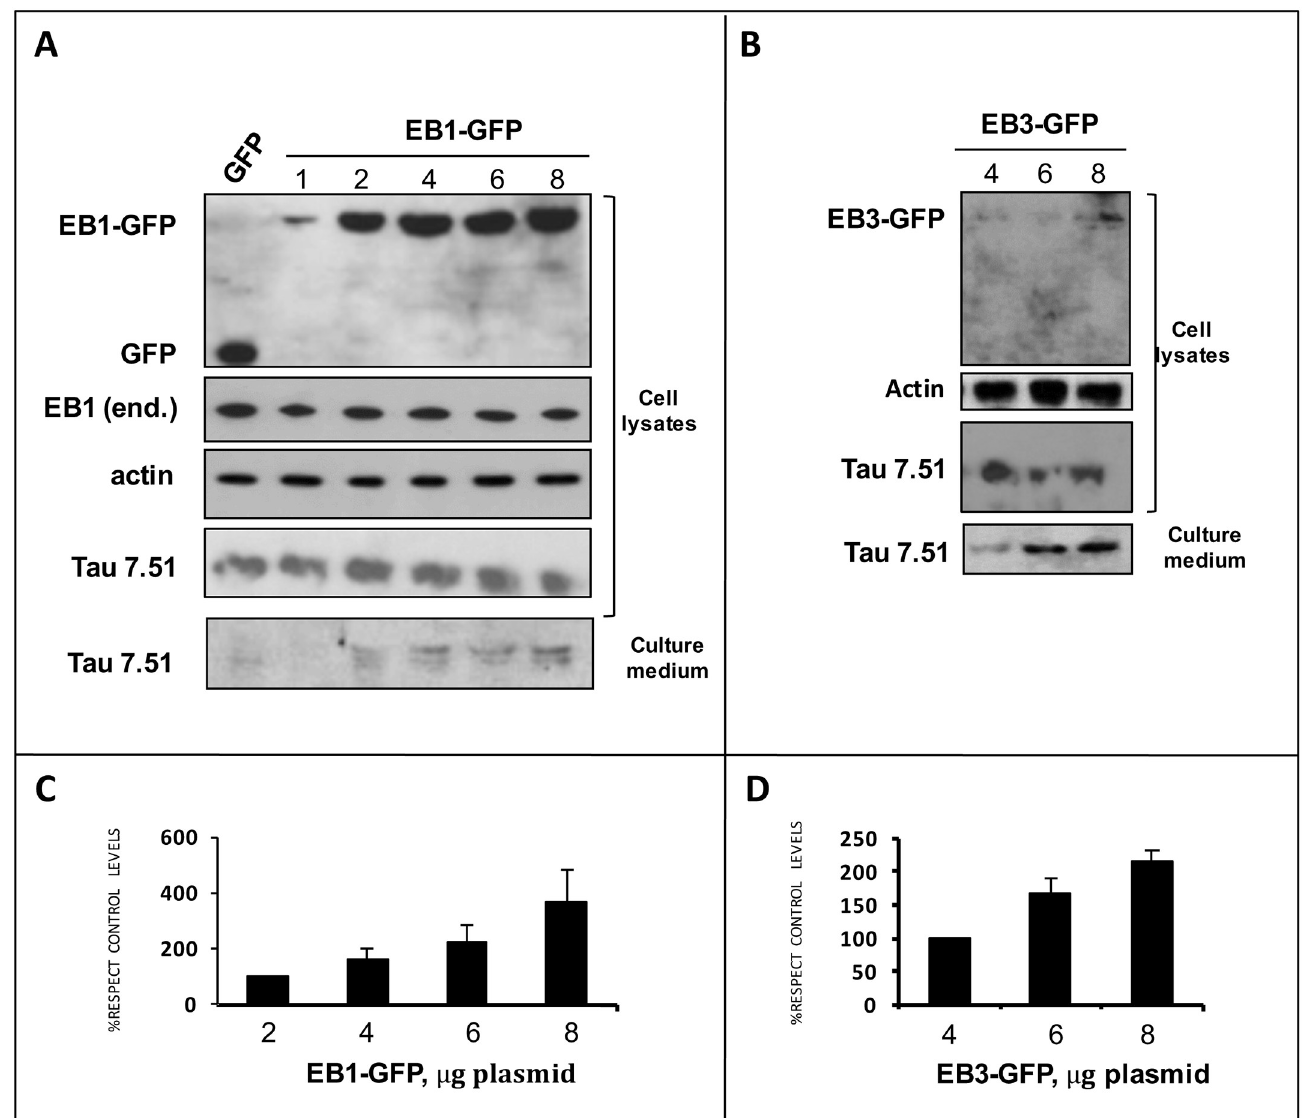
Fig 4. Overexpression of EB proteins facilitates tau secretion. A) Increasing amounts of EB1 protein were expressed in HEK-293-tau3R cells ( μ g plasmid per well). Increased EB1 expression levels (assessed with an anti-GFP antibody, upper panel) correlate with increased amounts of secreted tau observed in the culture medium (lower panel). Endogenous levels of EB proteins (EB1 end.) and intracellular tau remain unchanged. B) Similar results were obtained for EB3, although EB3 levels were much lower than of EB1, upon transfection (in line with this, endogenous levels of EB3 were barely detectable in these cells (data now shown)). A tau increase in the culture media was observed with an anti-tau antibody. No differences in intracellular tau levels were observed. C) Quantification of the data from A). D) Quantification of the data from B).